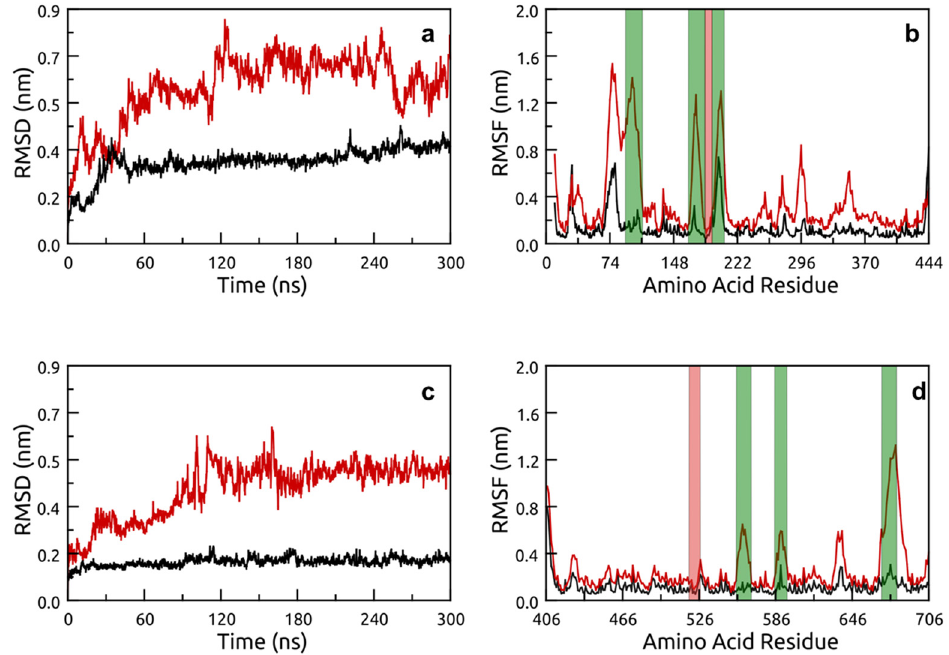
Figure 4. Backbone root-mean-square deviation (RMSD) and root-mean-square fluctuations (RMSF). ( a , b ) P-As and ( c , d ) T-Pf at 300 K (black) and 400 K (red). Identified primary floppy loops are highlighted in green with active sites in red.